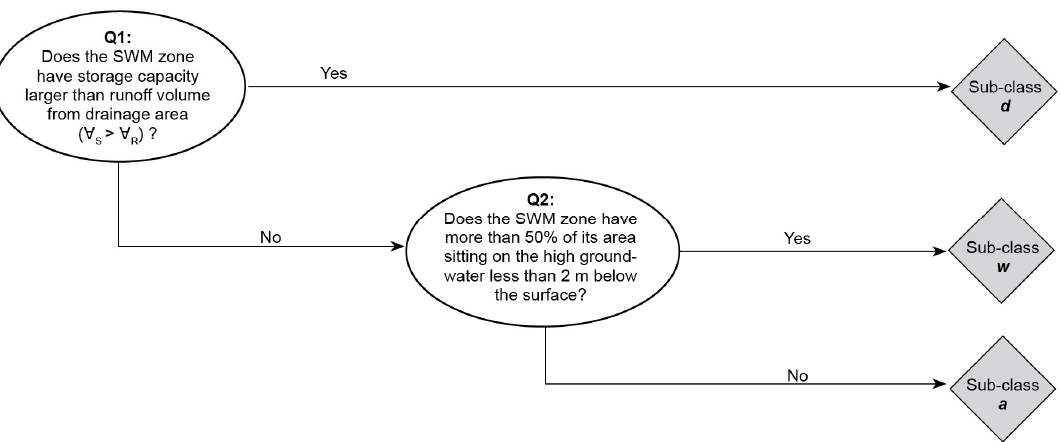
Figure 7. Decision tree for categorising SWM zones in each FMC class into sub-classes according to their key limiting factor: d = the size of drainage area, w = the high groundwater level, and a = the amount of potential GSI area.